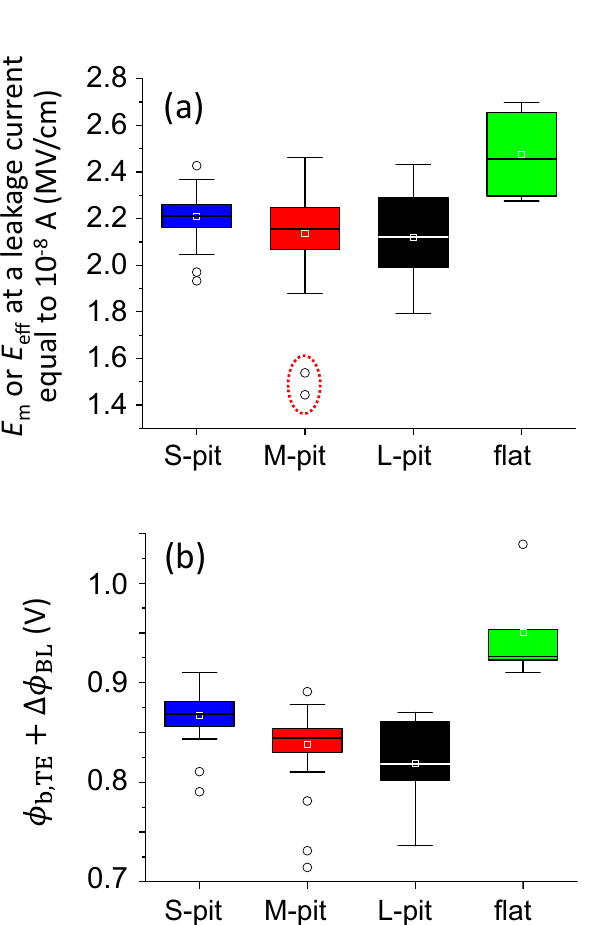
Figure 9. Box plots of ( a ) E eff or E m values at a leakage current of 10 –8 A and ( b ) Schottky barrier heights. These results were obtained from the J-V data presented in Fig. 2a–d. In ( a ), two M-pits generating large leakage currents are indicated by a dotted